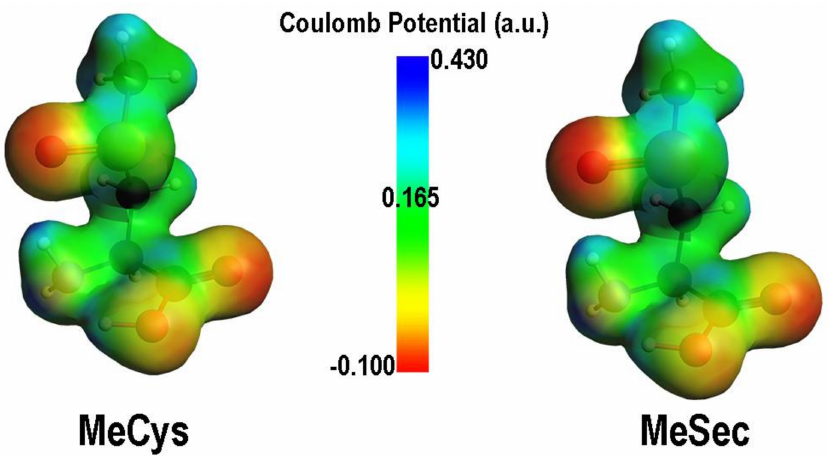
Figure 5. Comparison between MEPs of the oxidized forms of MeCys and MeSec. Adapted from